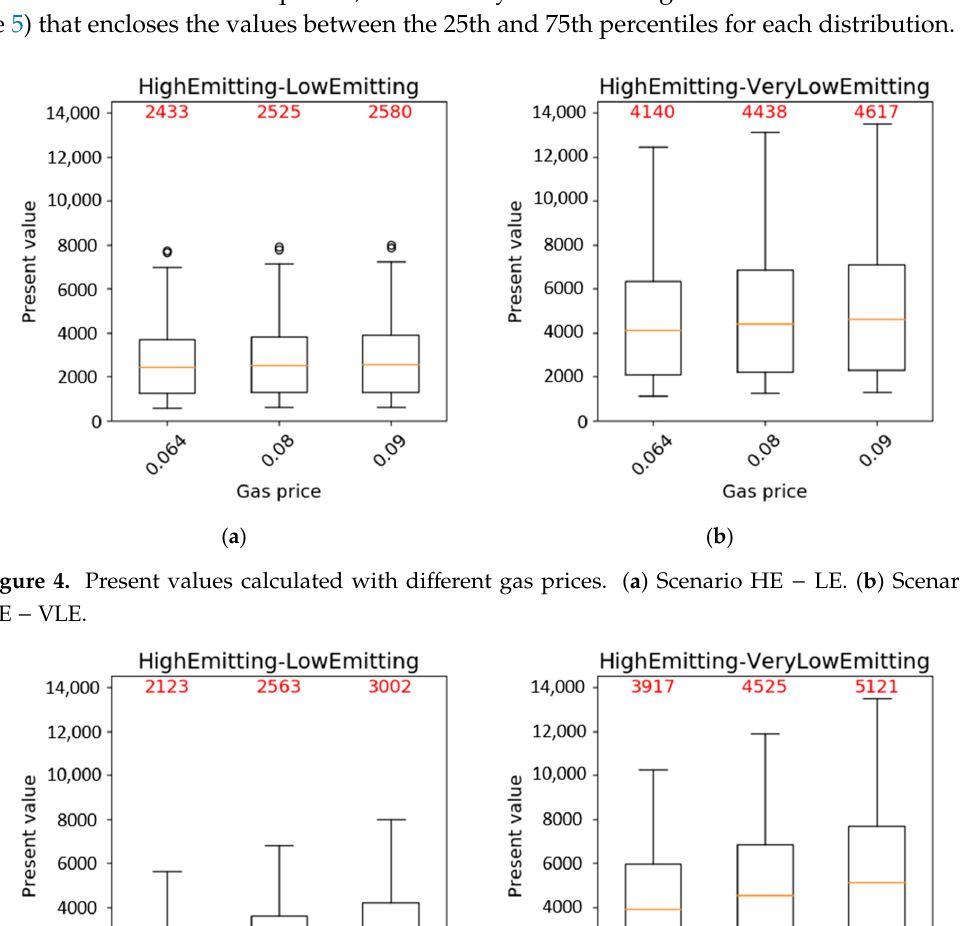
( b ) Figure 6. Present values calculated with different discount rates. ( a ) Scenario HE − LE. ( b ) Scenario HE − VLE. Lastly, Figure 7 highlights how the selection of a certain number of years is the most critical parameter. In the HE − LE scenario, the increase from 2 to 5 years leads to a median PV that is nearly 2.5 times higher (233% increase) while when considering 10 years, the PV becomes over 4 times higher (416%). A similar trend also happens in the HE − VLE scenario, although in this case, the absolute figures are more elevated. In both scenarios, the vertical dimension of the boxes (that shows how